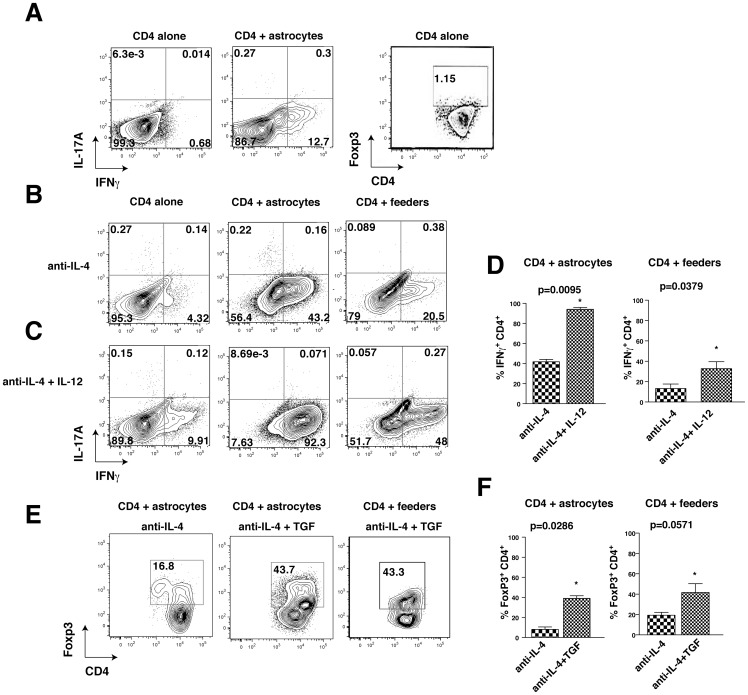
Astrocytes alone are sufficient to induce Th1 cell production.(A) CD4+ T cells were cultivated for 4 days on no feeder cells or on a monolayer of astrocytes. (B) CD4+ T cells were cultivated for 4 days on no feeder cells, on a monolayer of astrocytes, or on irradiated splenocyte feeder cells with 10 µg/mL anti-IL-4. (C) CD4+ T cells were cultivated for 4 days on no feeder cells, on a monolayer of astrocytes, or on irradiated splenocyte feeder cells with 10 µg/mL anti-IL-4 and 10 ng/mL IL-12. (A–D) IFNγ-producing, Foxp3 expressing and IL-17A-producing CD4+ T cells were analyzed by flow cytometry after restimulation with ionomycin/PMA/BFA for 4 h. Flow cytometry analyses were quantified and expressed as mean ± s.e.m. (for the data in D: n = 4–8, Mann-Whitney test, *p<0.05 compared with cells incubated without anti-IL-12). (E, F) CD4+ T cells were cultivated for 4 days on a monolayer of astrocytes or on irradiated splenocyte feeder cells with 10 µg/mL anti-IL-4, with or without 5 ng/mL TGFβ. Foxp3-expressing cells were analyzed by flow cytometry. Flow cytometry analyses were quantified and expressed as mean ± s.e.m. (n = 4, Mann-Whitney test, *p<0.05 compared with cells incubated without TGFβ).